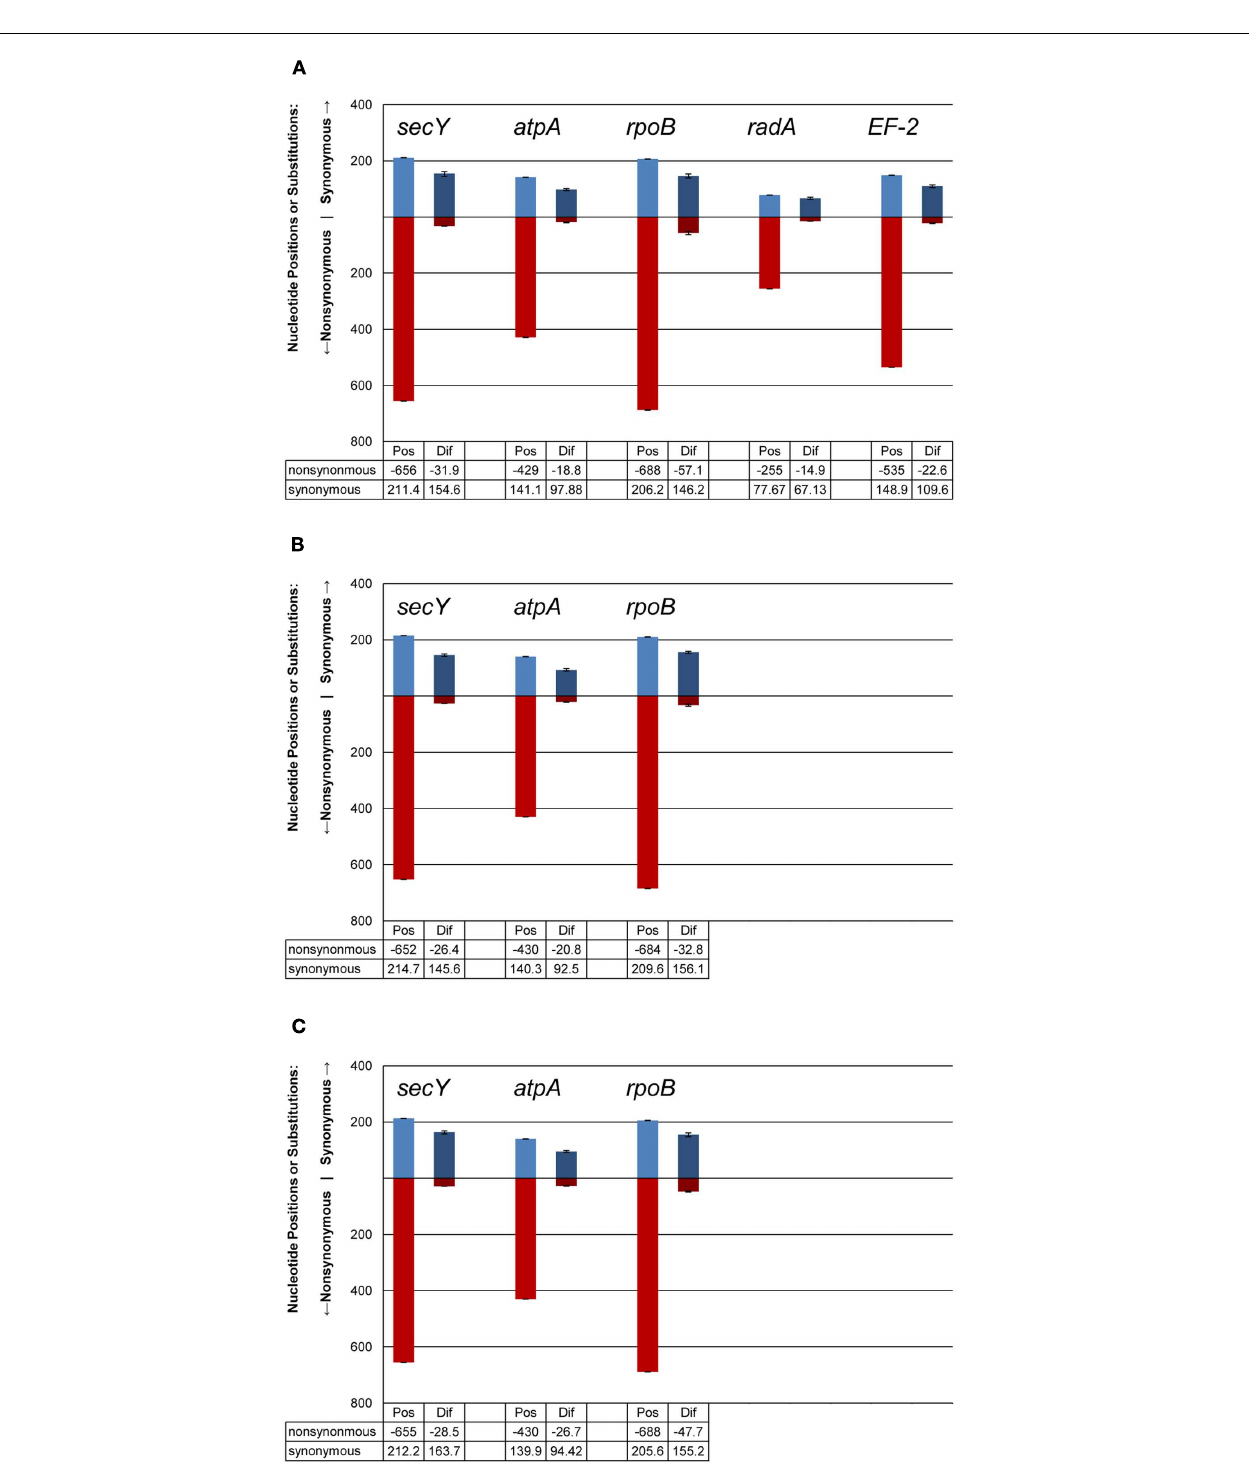
isolates from the MAR compared to the EPR. Mean values shown on graph, range given with bars. Abbreviations are: Pos, possible synonymous or non-synonymous nucleotide positions; Dif, actual synonymous or non-synonymous